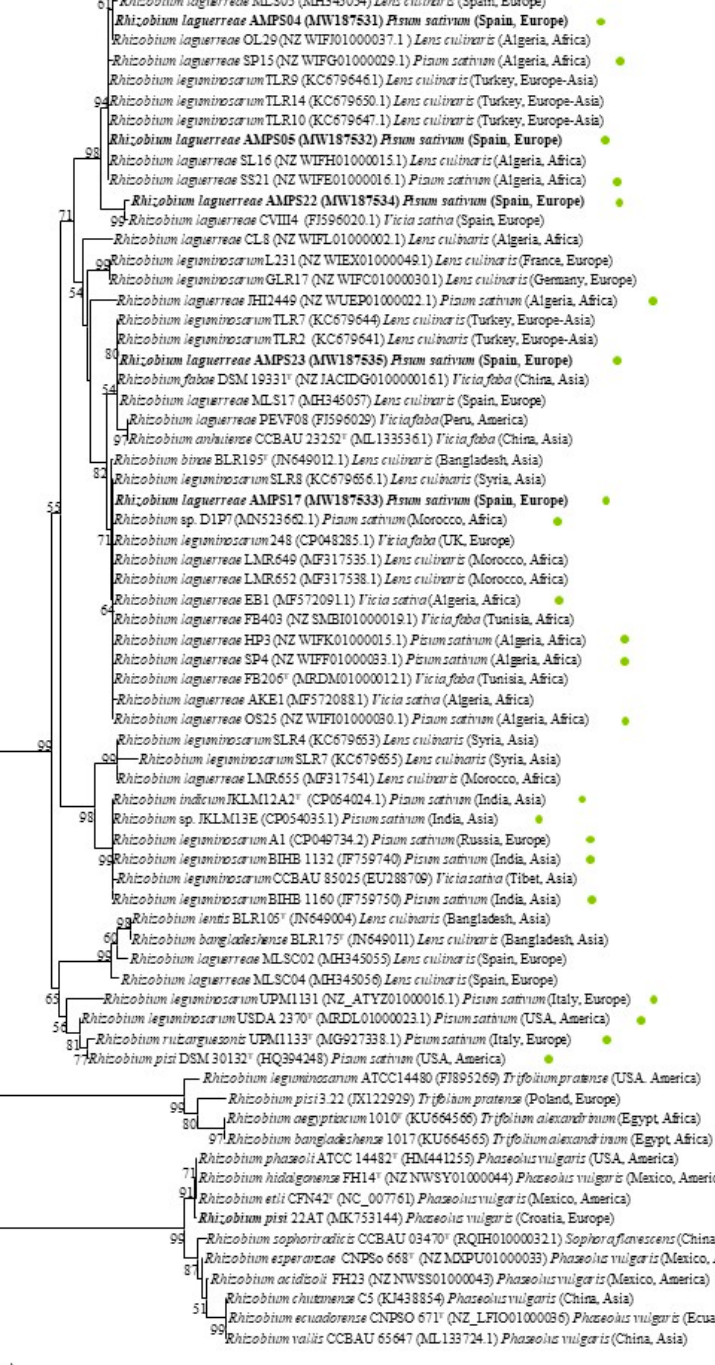
Figure 4. Neighbor-joining unrooted phylogenetic tree based on nodC gene sequences (370 nt) showing the position of representative strains from each group within the symbiovars viciae and phaseoli. Bootstrap values calculated for 1000 replications are indicated. Bar: 5 nt substitution per 100 nt. Filled green circles indicated the strains isolated from Pisum sativum worldwide.